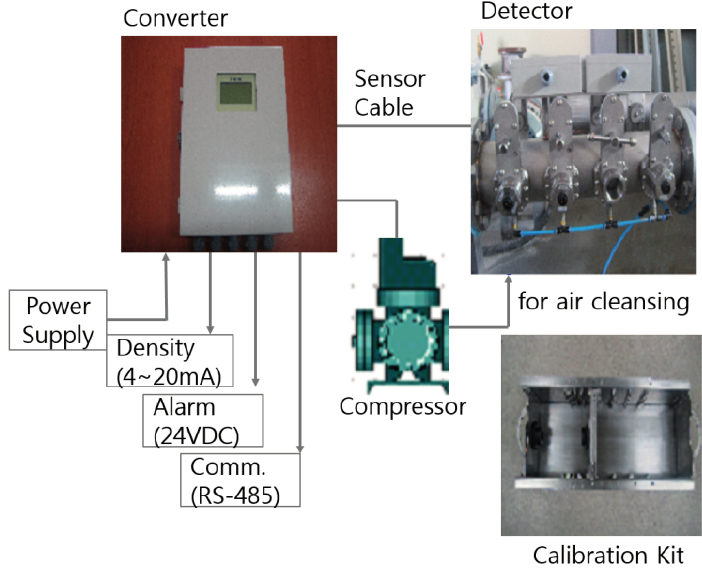
Figure 2. Structure of the ultrasonic concentration